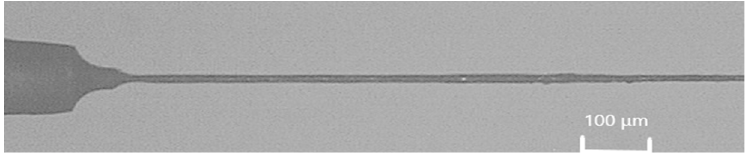
Figure 9. Microelectrode tool with diameter of 0.007 mm.